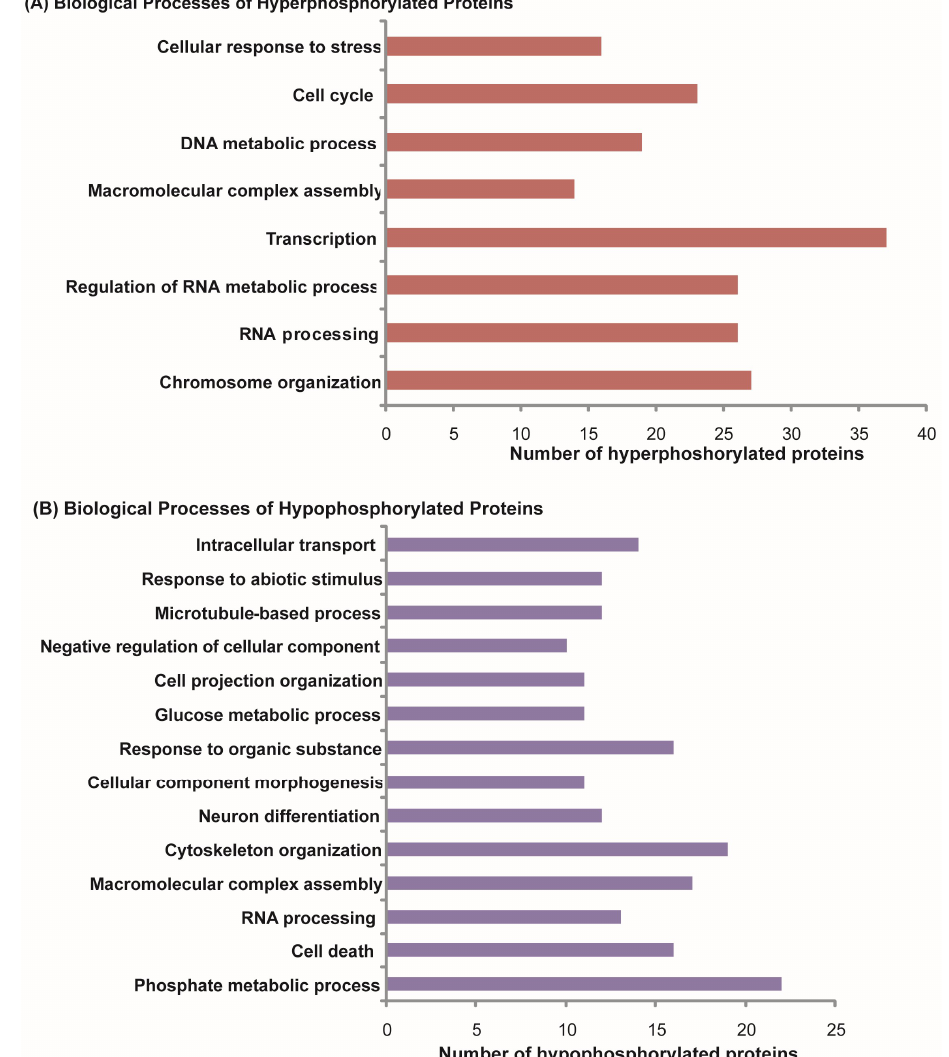
Figure 2. Biological processes enriched in ( A ) hyperphosphorylated proteins and ( B ) hypophosphorylated proteins of RB. Gene ontology (GO) analysis of hyperphosphorylated proteins identified various biological processes required for active cell proliferation such as cell cycle, transcription, and chromosome organization. Biological processes such as cell death and neuron differentiation were found in hypophosphorylated proteins analysis.